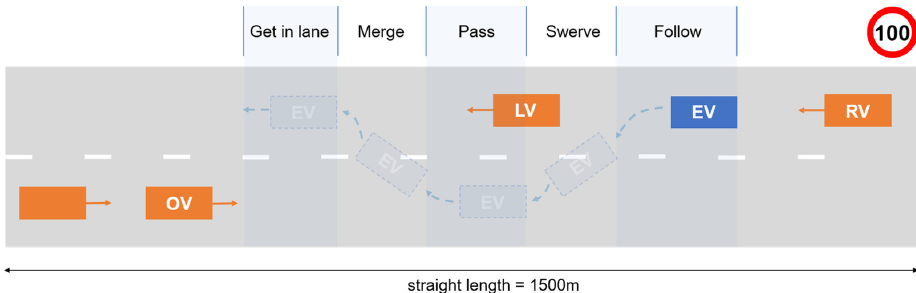
Figure 2. Schematic illustration of the overtaking scenario comprising different road users/agents and divided into five temporal and spatial stages. EV = ego vehicle, LV = lead vehicle, RV = rear vehicle, OV = oncoming vehicle.